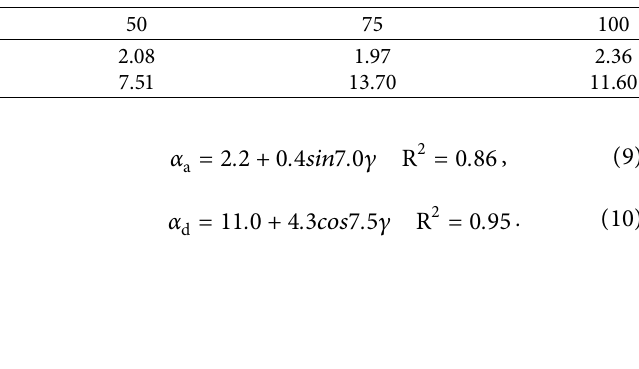
Table 5: Coefficients α